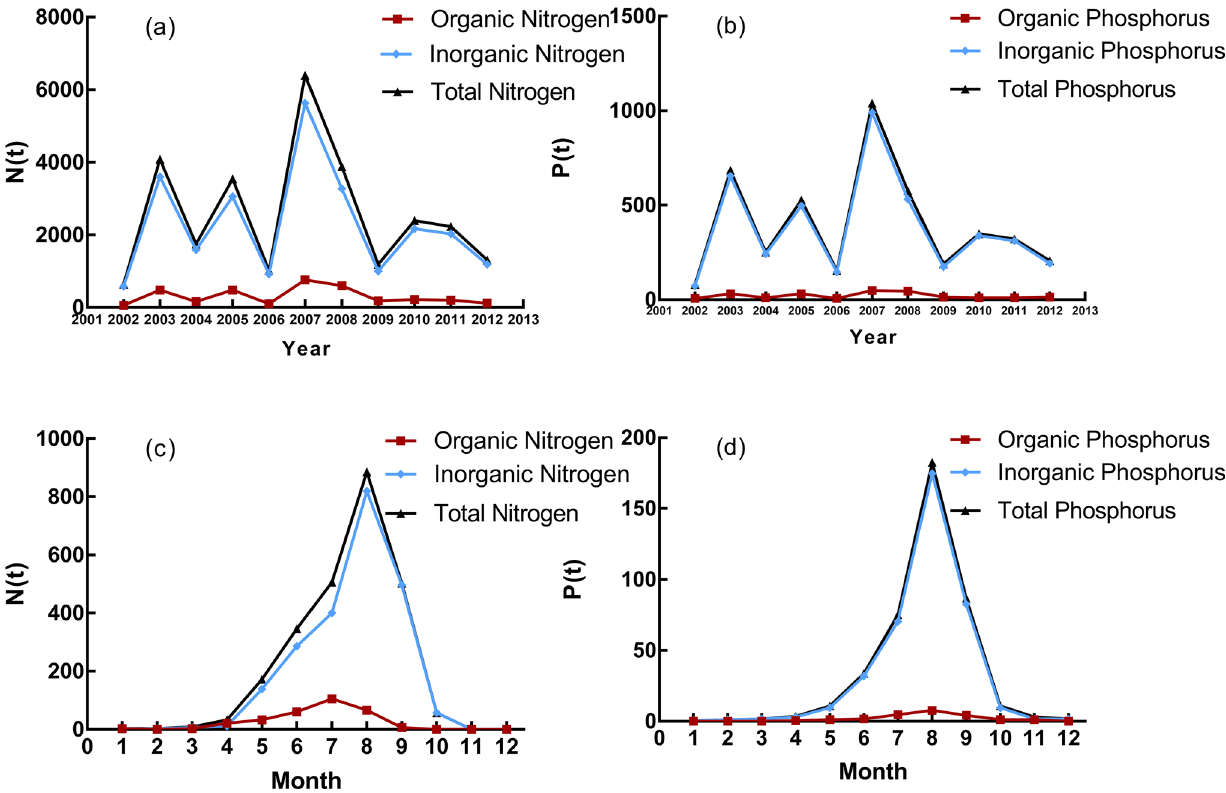
Fig. 9 Annual and monthly average emissions of nitrogen and phosphorus in Dagu River Basin from 2002 to 2012: a interannual nitrogen change; b interannual phosphorus change; c monthly average nitrogen change; d monthly average phosphorus change